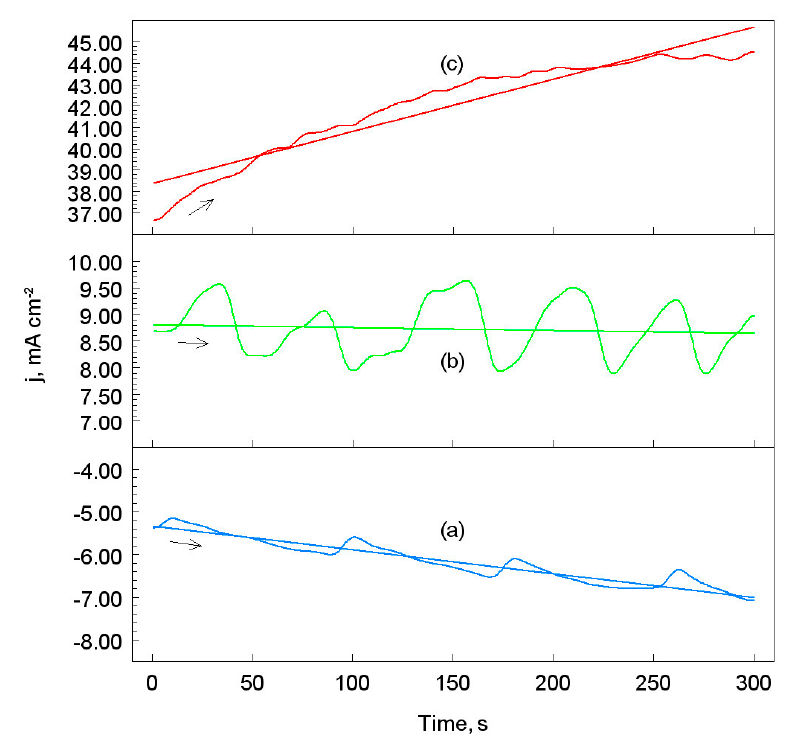
Figure 10. Chronoamperometric curves of O60 nickel coating obtained for: ( a ) − 650, ( b ) − 400, and ( c ) 150 mV. The solution contained 1.2 M Cl − , pH 1.5. (Straight lines refer to the average current density